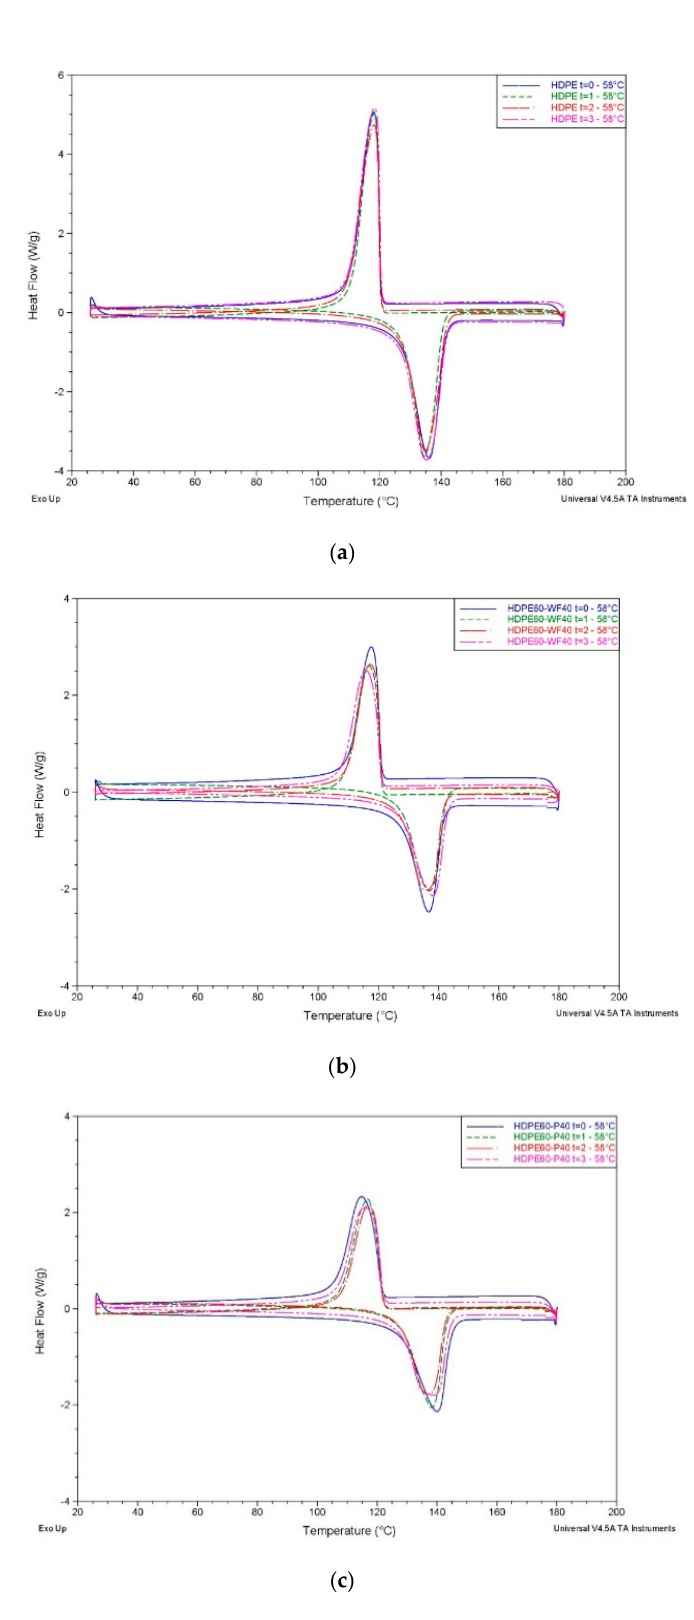
Figure 5. DSC thermograms for HDPE-based samples after three months buried at 58 ◦ C: ( a ) neat HDPE; ( b ) HDPE60-WF40; ( c )